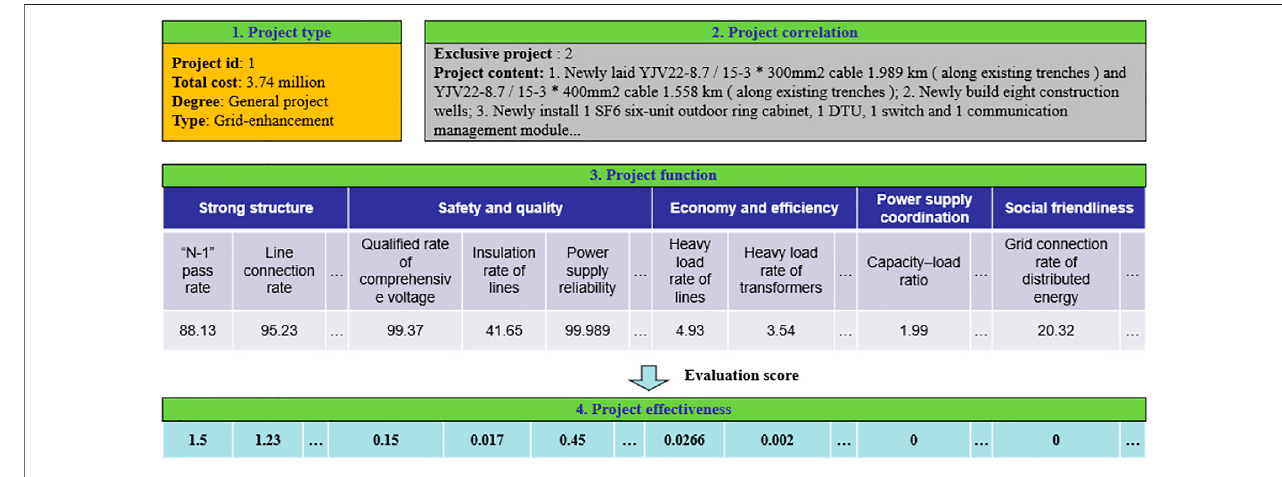
FIGURE 3 | Example of project label content display.